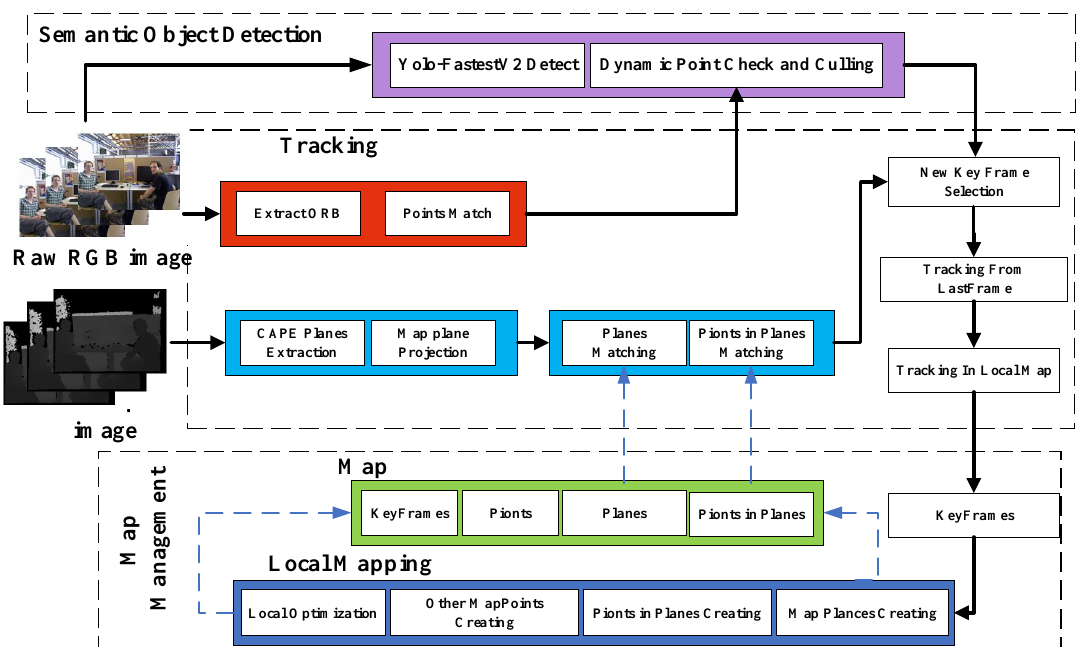
Figure 1. Framework of the YPD-SLAM